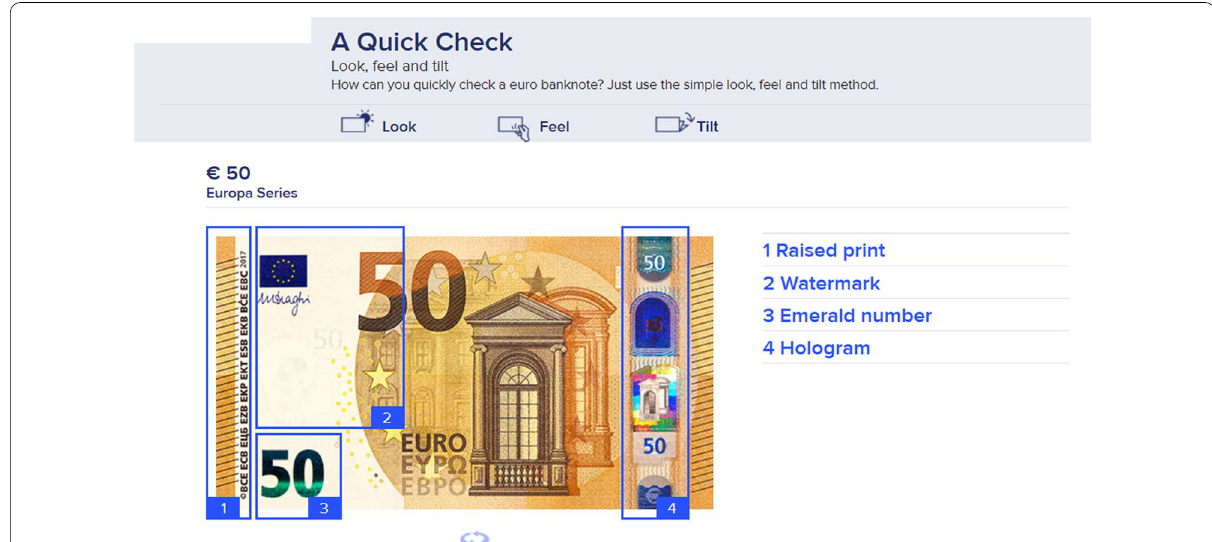
Fig. 1 Instructional image on how to check the most prominent security features of a EUR 50 banknote quickly. Source: DNB website (www. dnb. nl/ echto